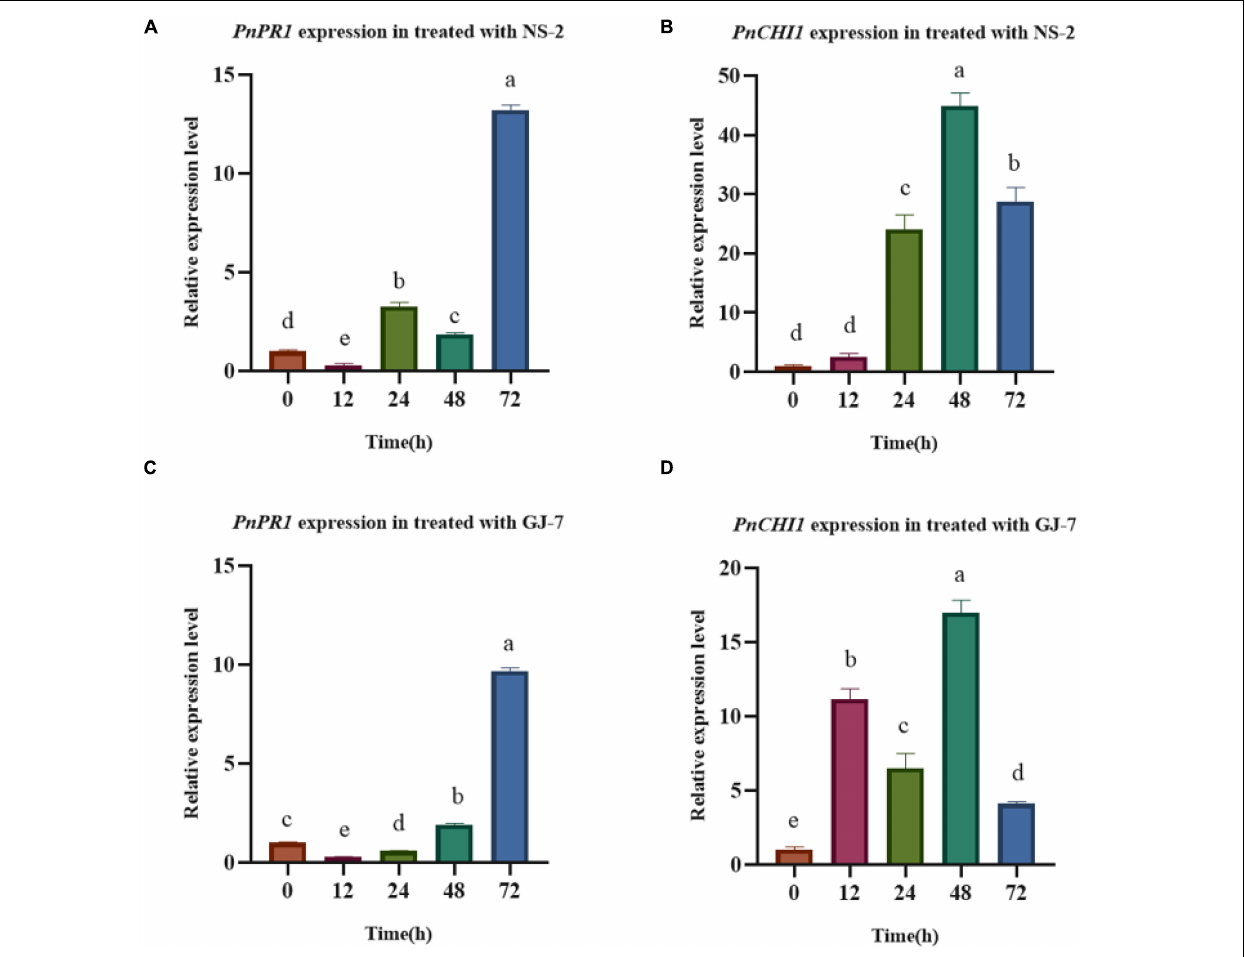
FIGURE 8 | Analysis of defense response in Panax notoginseng roots treated with the strains NS-2 and GJ-7. (A,B) Relative expression level of PnPR1 (A) and PnCHI1 (B) in P. notoginseng roots treated with strain NS-2. (C,D) Relative expression level of PnPR1 (C) and PnCHI1 (D) in P. notoginseng treated with the strain GJ-7. Expression levels were normalized relative to the control at the 0 h time point. Data were analyzed by one-way ANOVA with Duncan’s multiple range test, and error bars represent standard error of three biological and three technical replicates ( n = 9). Different lowercase letters indicated significant differences among treatments ( P <